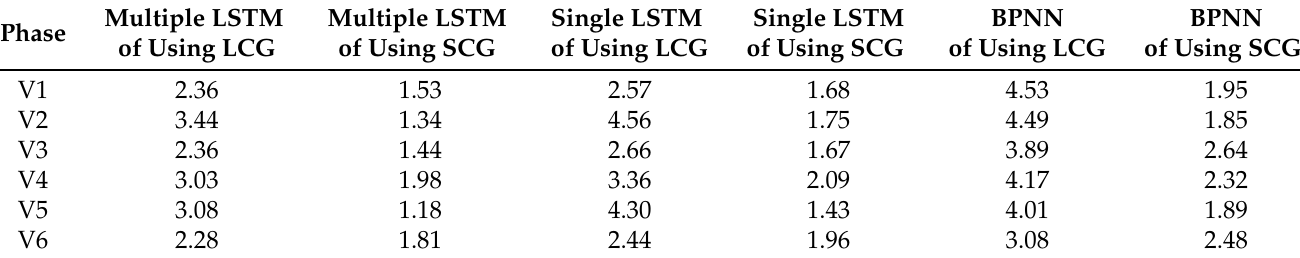
Table 3. The RMSE of state for different operating materials and models.